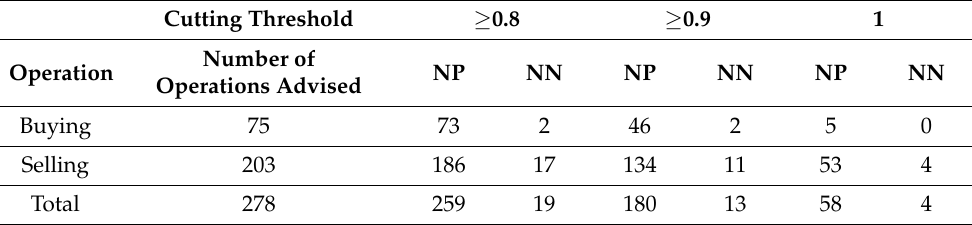
Table 2. Effectiveness of the models regarding given thresholds. NP = “Number of positive returns”, NN = “Number of negative